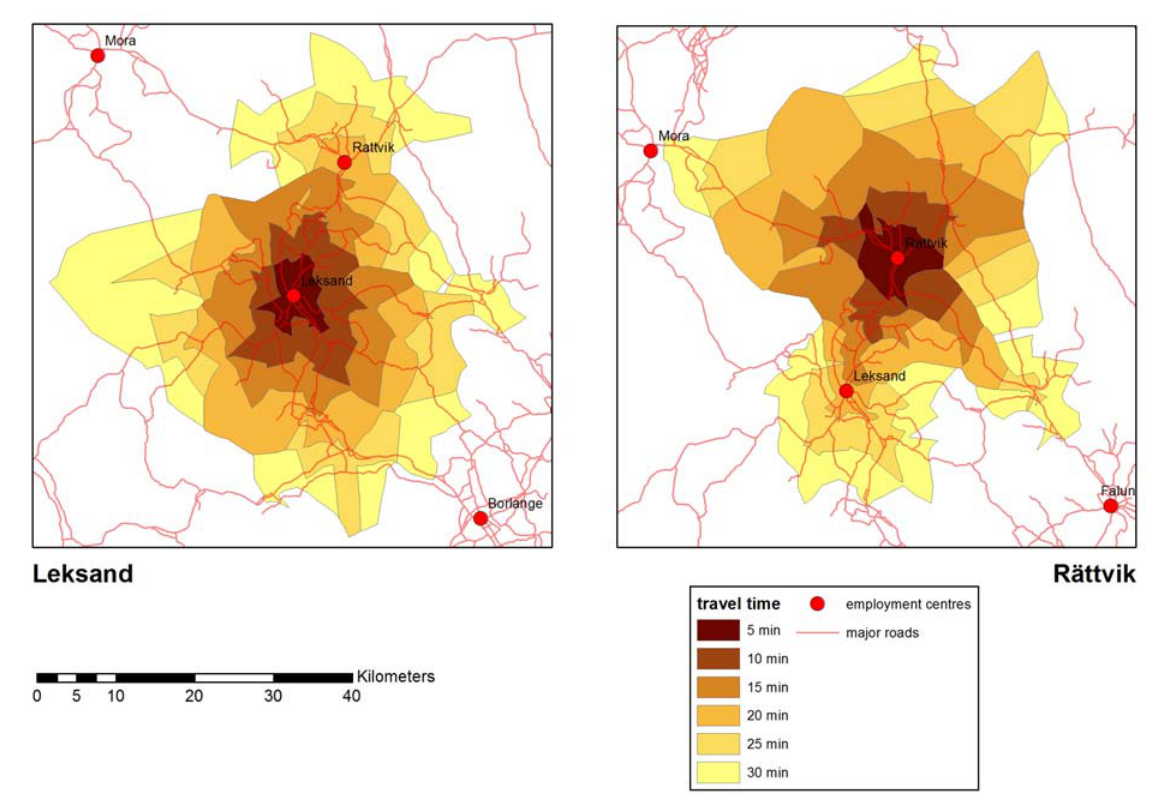
Figure 11. Voronoi drive time isochrones for Leksand and Rättvik.